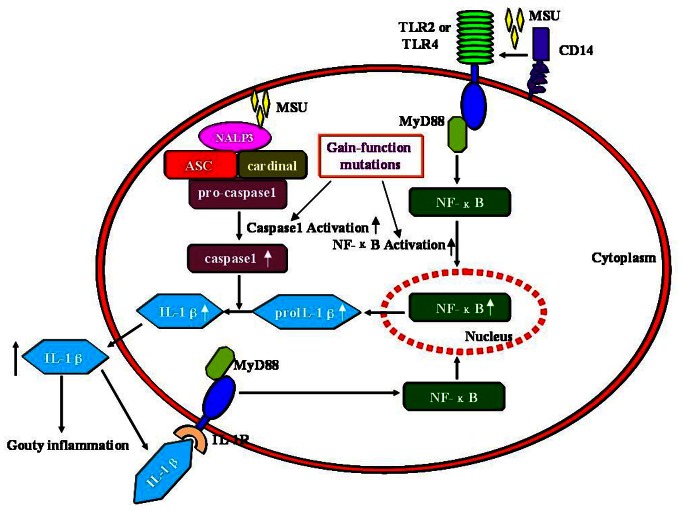
Innate immunity and gout susceptibility genes.Innate immunity components associated with TLR2, TLR4, CD14 and NALP3 inflammasome are involved in MSU-mediated inflammation through activation of TLRs-MyD88 dependent NFκB signaling, the NALP3 inflammasome and IL1β-MyD88 dependent IL1R signaling. Gain-of-function mutations in TLR2, TLR4 or CD14 will enhance MSU-mediated TLRs-NFκB activation, increasing the synthesis of proIL1β; the gain-of-function mutations in the NALP3 inflammasome, which include NALP3 and CARD8, will enhance MSU-mediated NALP3 inflammasome activation and increase IL1β processing. Elevated IL1β is involved in gouty inflammation.